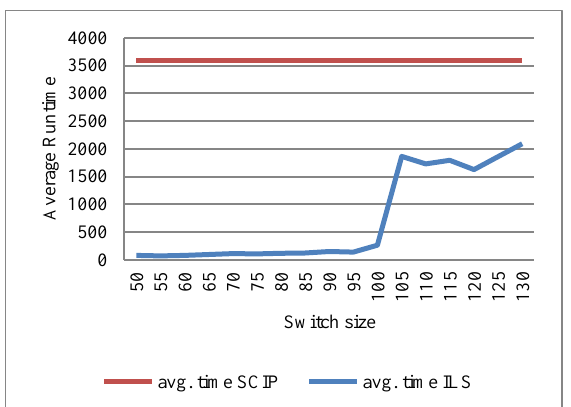
Figure 5. Average runtime of the ILS algorithm on the instances of the same size compared to